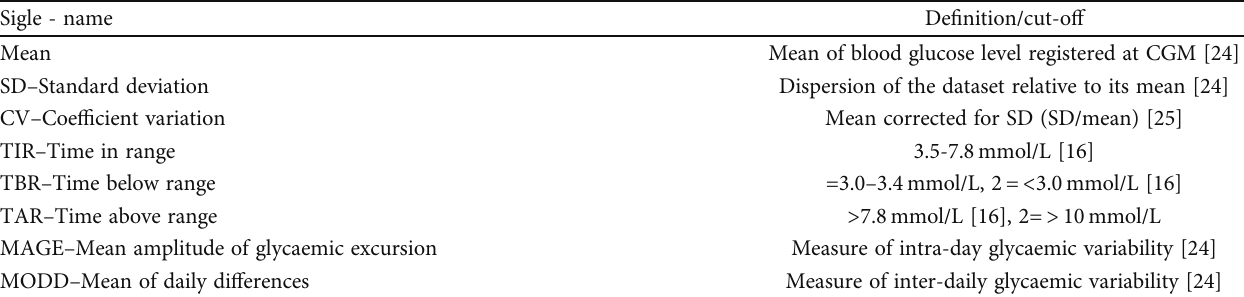
Table 1: Continuous glucose monitor parameters used for data